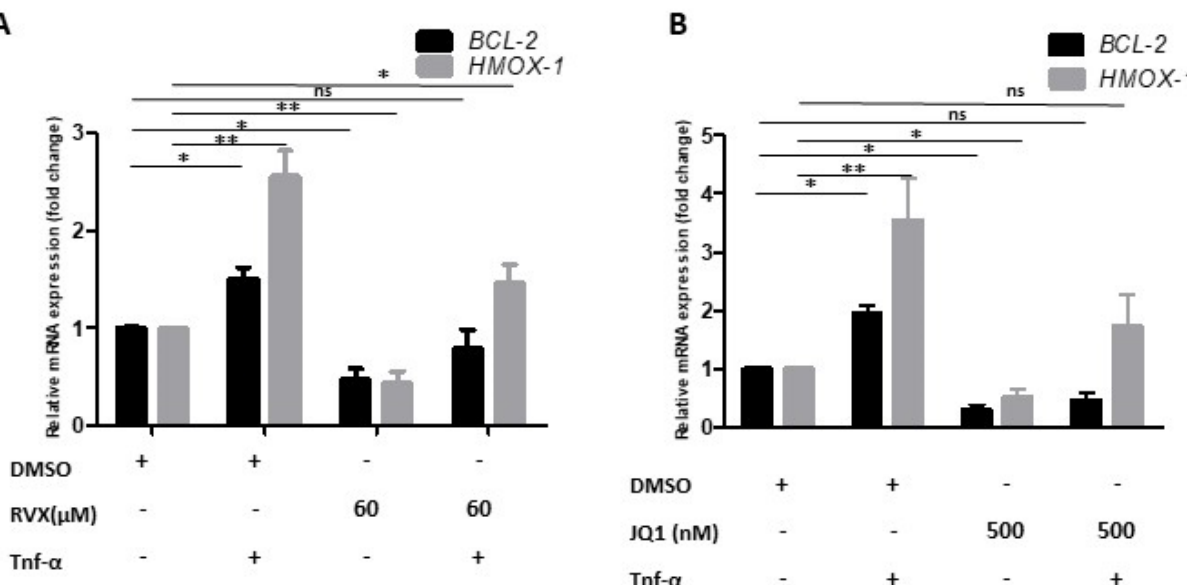
Figure 3. BRD4 inhibitor efficacy. ( A ) Bar graph showing relative mRNA levels of BCL2 and HMOX-1 after normalization to house-keeping gene GAPDH, in DMSO control, TNF- α -only, RVX208, and RVX208, followed by TNF- α treatment (left panel). ( B ) DMSO control, TNF- α -only, JQ1, and JQ followed by TNF- α treatment (right panel). One-way ANOVA with Tukey’s post-test used. Values are mean ± SD of three biological replicates (** = p < 0.01, * = p < 0.05 and ns = non significant).